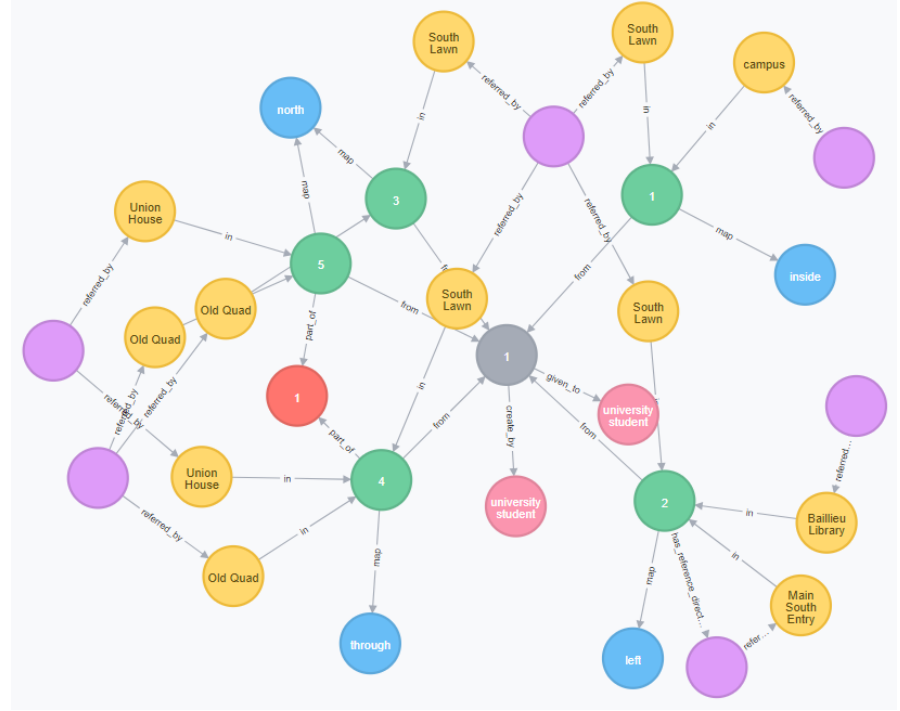
Figure A5. The resulting extended place graph database of the place description example. Gray: description; Pink: user; Green: n -plet; Blue: (mapped) spatial relation; Red: route; Yellow: place reference; Purple: